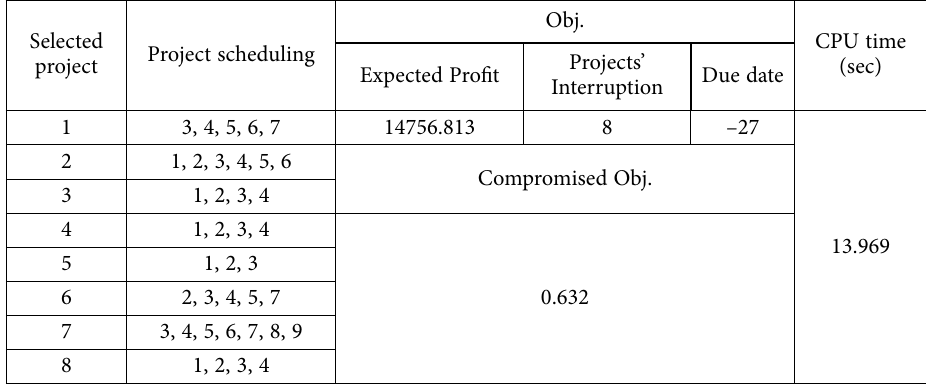
Table 6. The result of the fifth scenario Selected